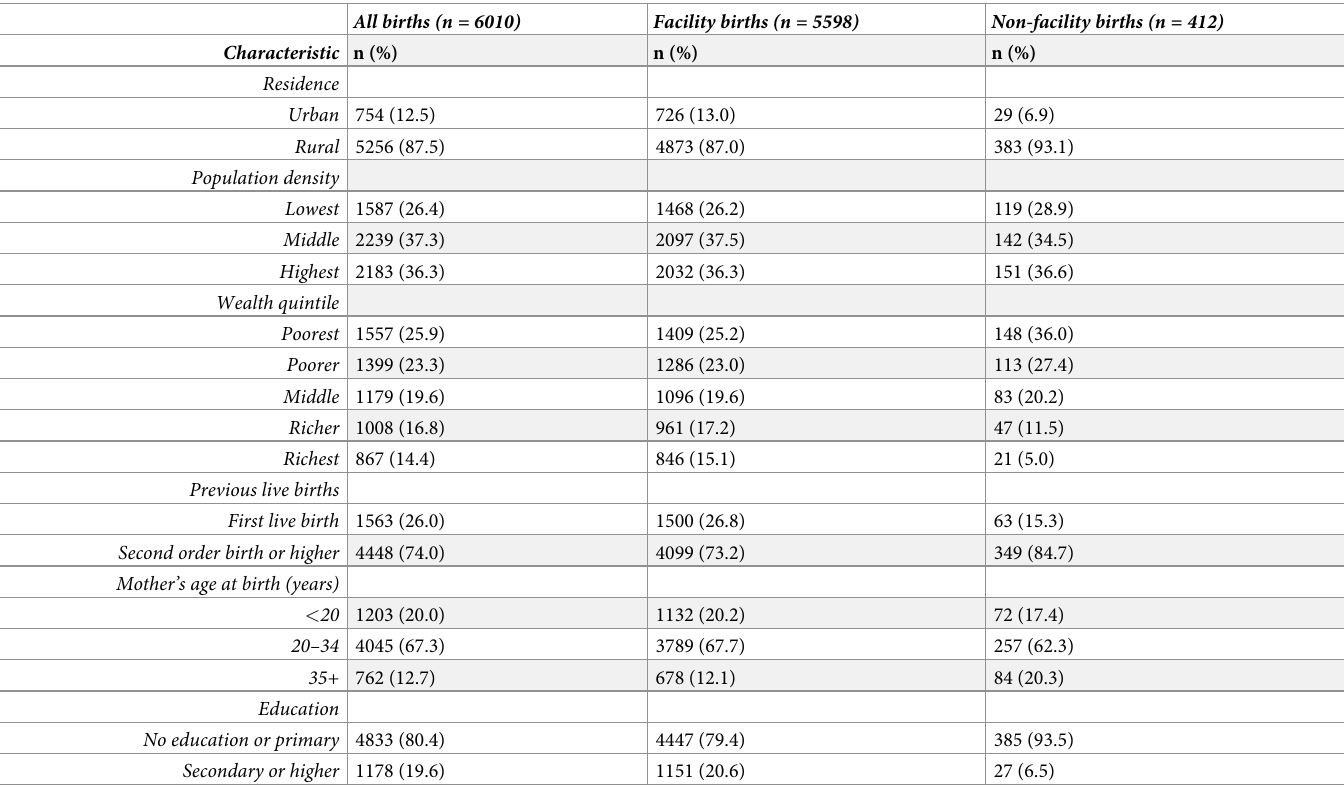
Table 1. Background characteristics for the most recent births for local area residents in the two years preceding the